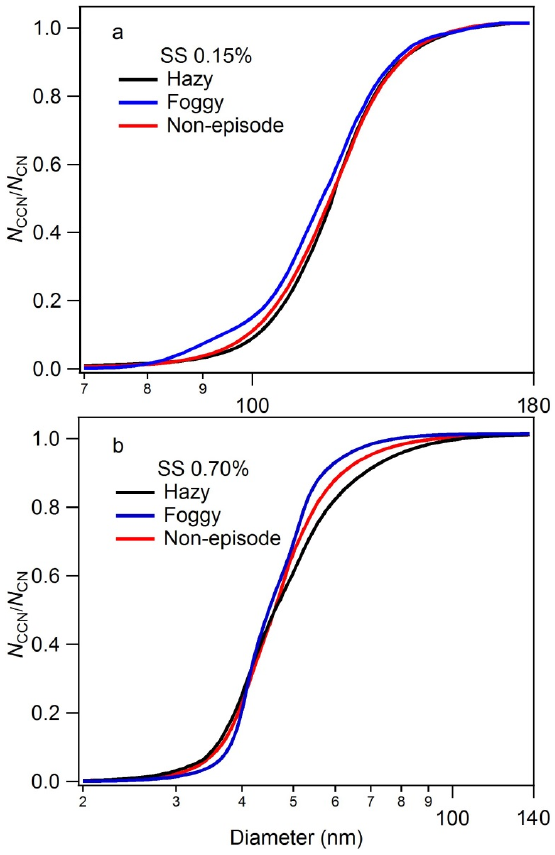
Figure 7. The average size-resolved CCN activation ratio at SS of (a) 0.15% and (b) 0.70% during the hazy, foggy and non-episode periods.